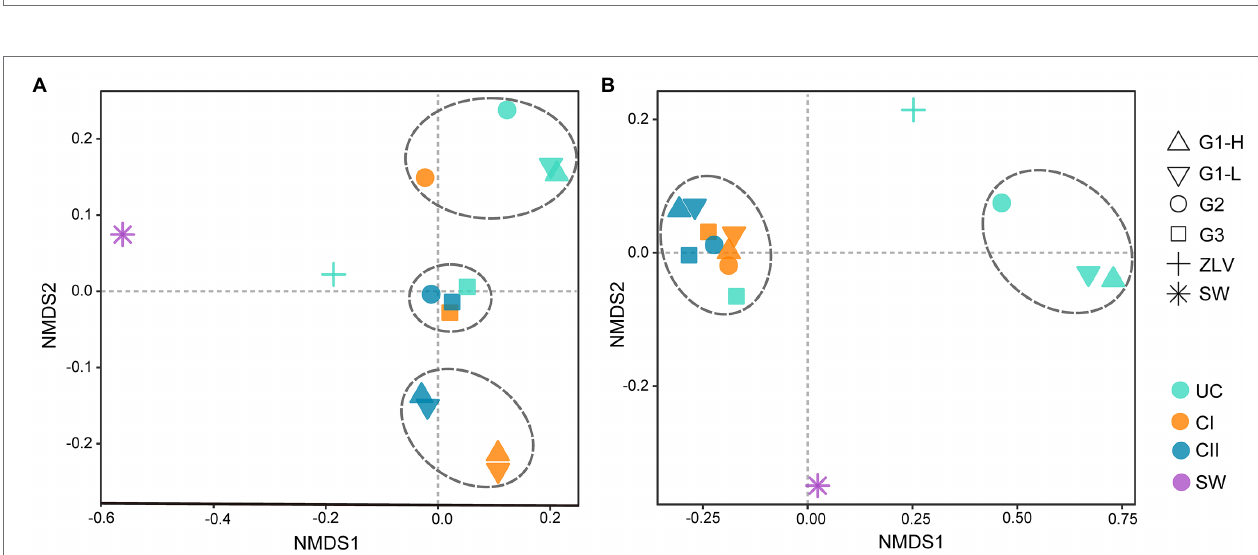
FIGURE 4 | NMDS Analysis based on Weight-UniFrac distance matrix. (A) NMDS analysis of bacterial communities; (B) NMDS analysis of archaeal communities. The dashed lines divide the groundwater samples from the monitoring wells G1, G2 and G3 into different groups. Statistical analyses supported the groups with statistical significance ( Supplementary Table 5 ). G1, G2 and G3 indicate monitoring site. ZLV, groundwater outlet at Zhuoluo; SW, seawater; UC, unconfined aquifer; CI, confined aquifer I; CII, confined aquifer II; H, high tide; L, low